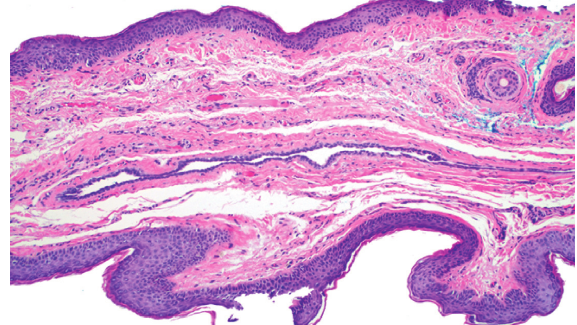
Figure 2: A cystic space lined by two layers of epithelial cells. Decapitation secretion can also be seen in the cyst-like space (100x H and